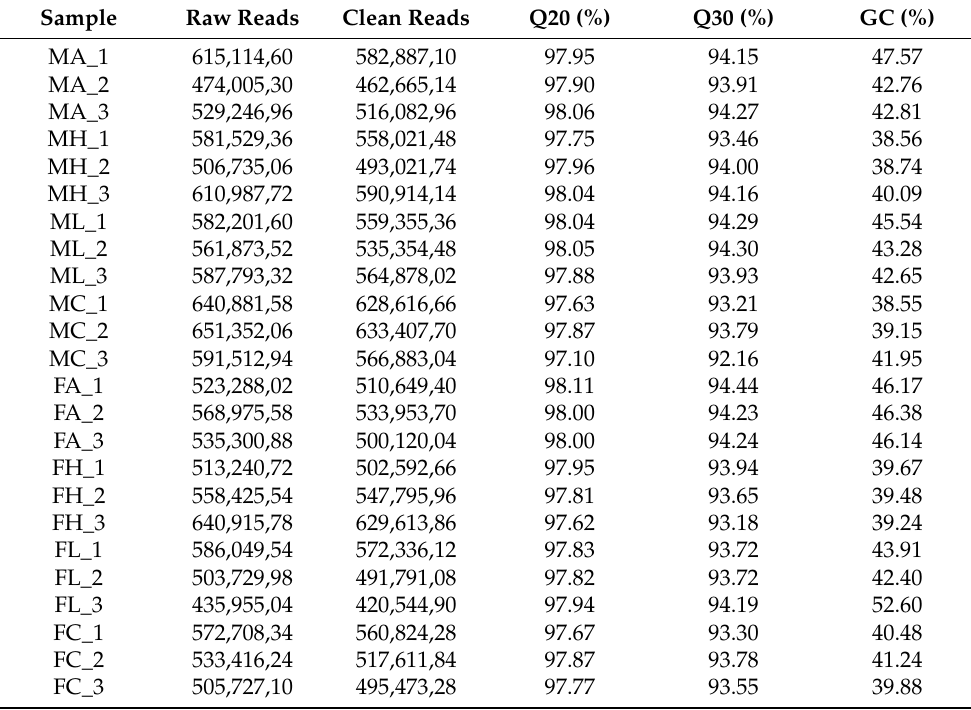
Table 1. Summary of the transcriptome sequencing data from T. yunnanensis .